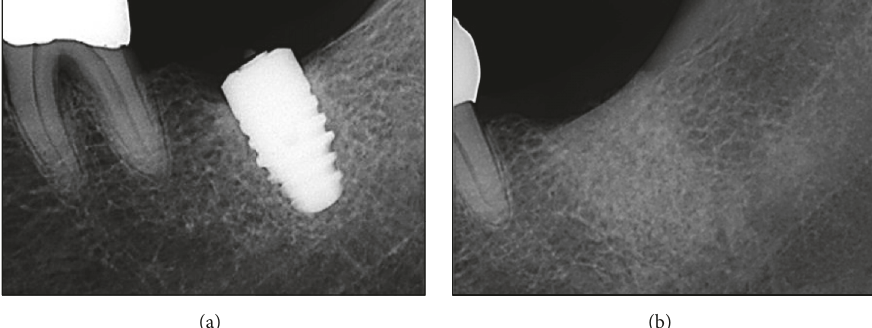
Figure 3: Postoperative radiographic view (periapical X-ray image). (a) Implant fixture with a fractured abutment screw. (b) Implant removal site filled with a bone grafting material.